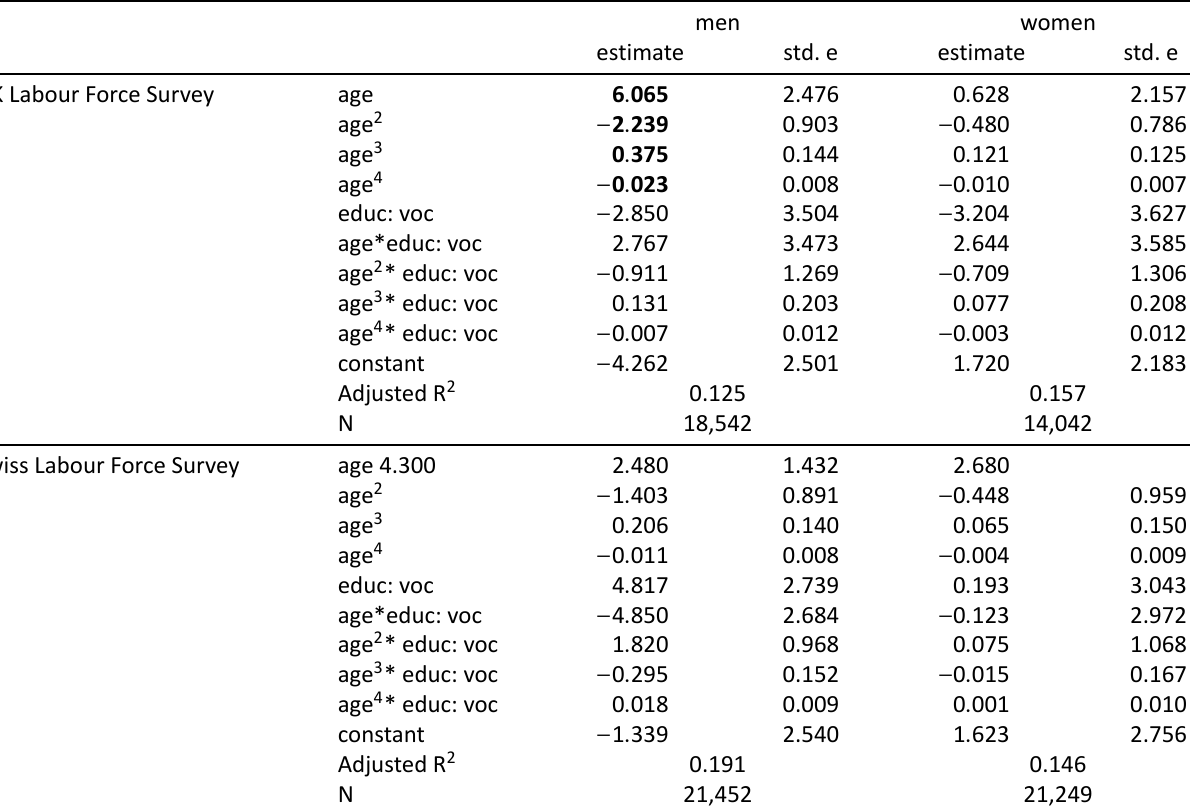
Table A3. OLS regression coefficients for log hourly wage. Source: UK Labour Force Survey 1993–2014 and Swiss Labour Force Survey 1991–2014, cohort